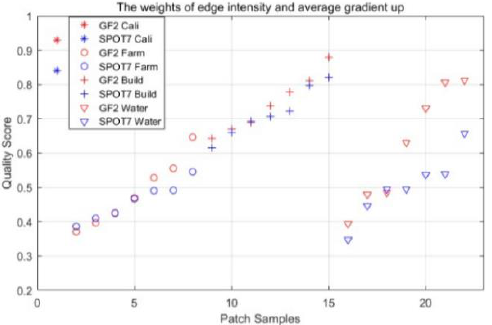
Figure 9. The results with high EI and AG weight Combining the feature vectors of the table 5, we can find that among these features, GF2 image has higher GSD, entropy, average difference, edge intensity and average gradient.